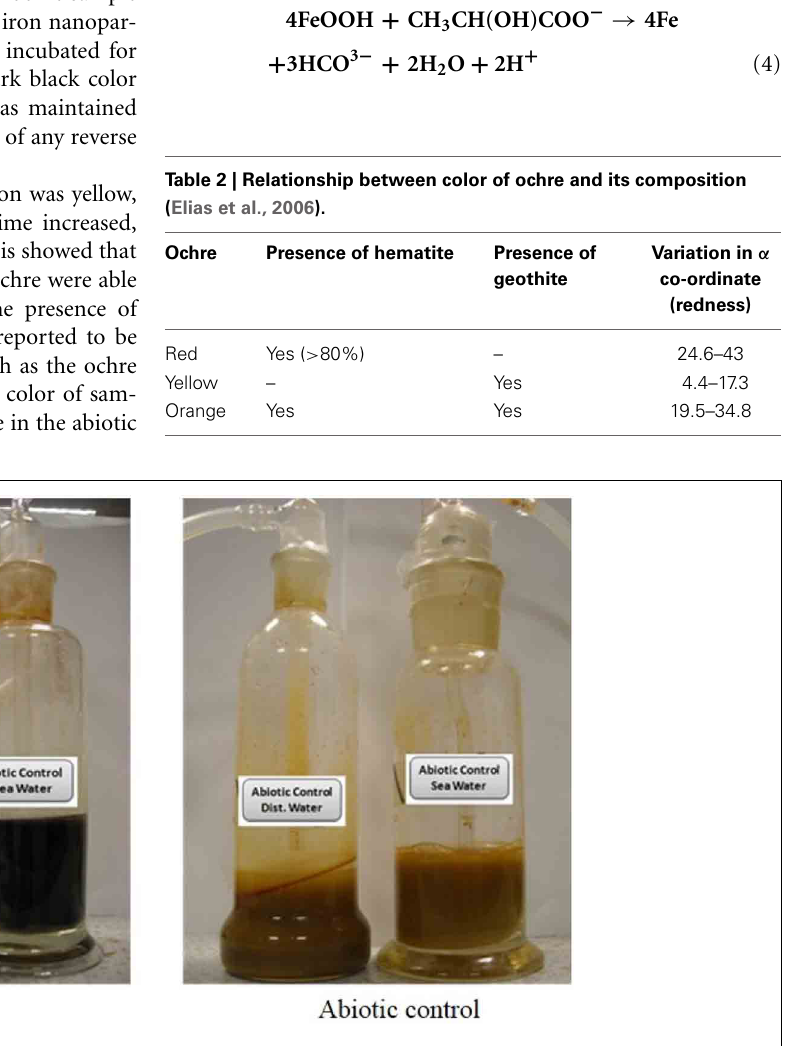
FIGURE 5 | Biotic and abiotic controls after 8 days of